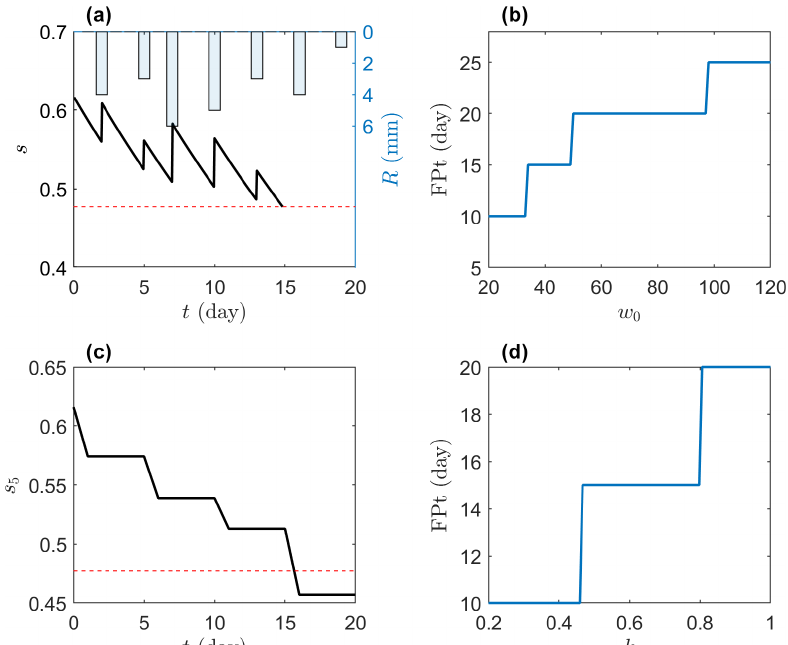
Figure 1. An illustrative example of drought occurrence. A water balance model in Sect. 2 is used to simulate time series of (a) rainfall, instantaneous soil moisture s , and (c) pentad-averaged soil moisture s 5 . The first passage time (FPT) from the 40th to the 20th percentile is calculated (b) by varying the soil water capacity w 0 and (d) by changing the rainfall rate by a factor of k . The parameters in panels (a) , (c) , and (d) are given as follows: potential evapotranspiration E max = 4mmd − 1 and water storage capacity w 0 =